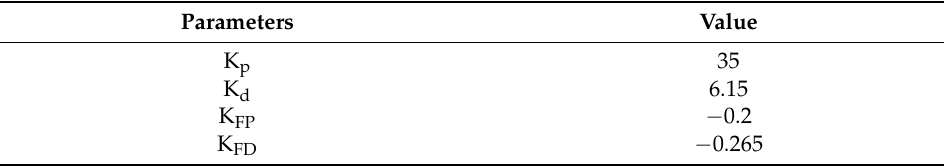
Table 5. Control parameters of the simulation. Figure 10. Plot of transfer function versus actual motor output for the same target angular velocity.